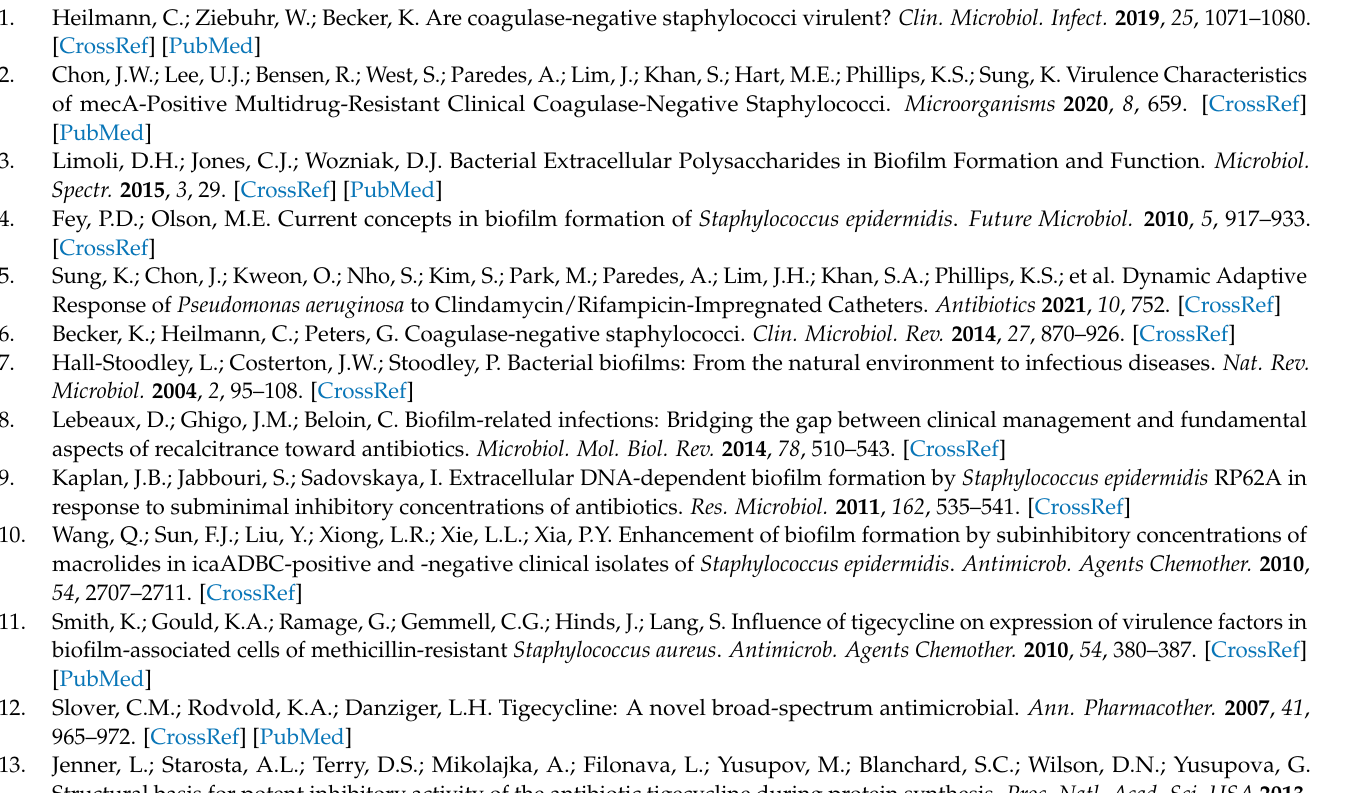
Table S3: KEGG pathways of down-regulated proteins; Figure S1: The ratio of FITC (live cells) to TRITC (dead cells) in